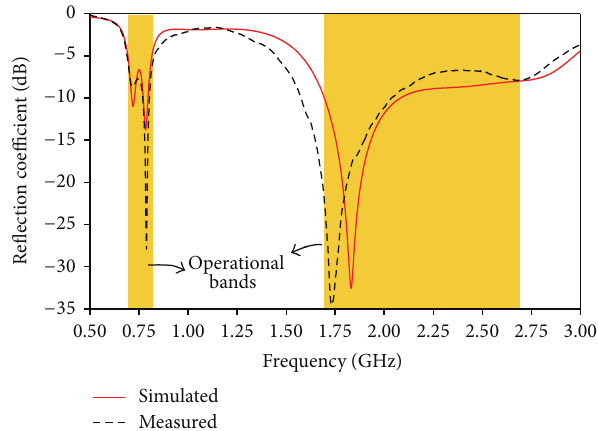
Figure 8: Simulated and measured reflection coefficients of the optimized antenna structure.